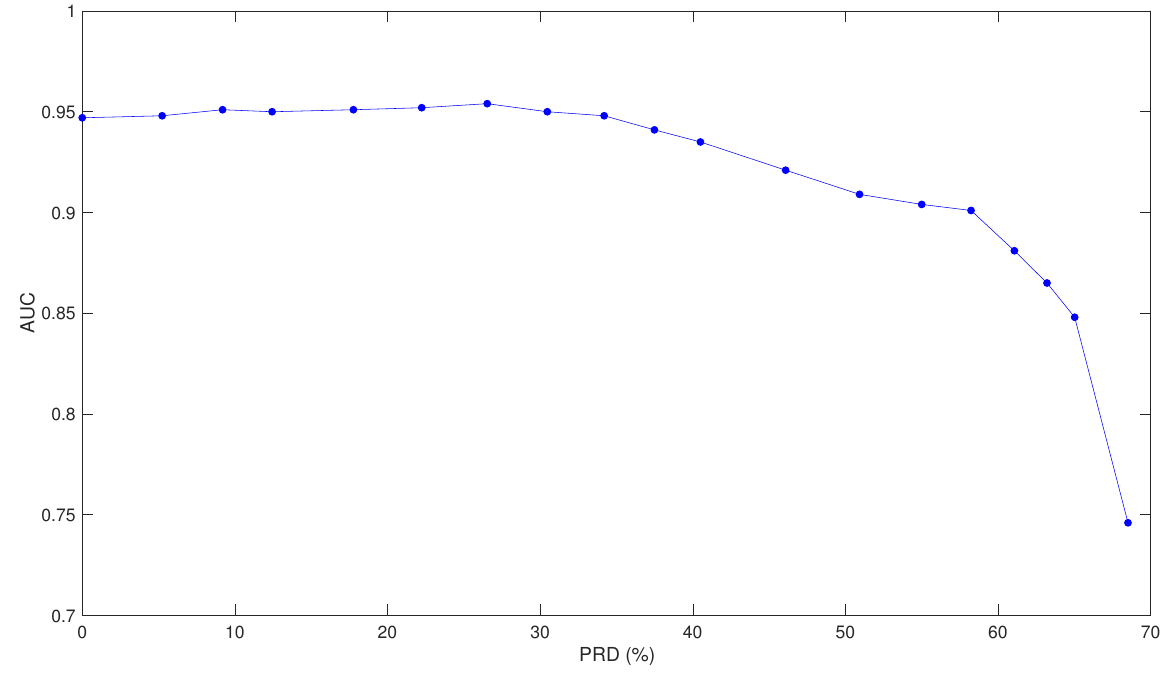
Figure 6. AUC versus PRD, averaged over all records in the test